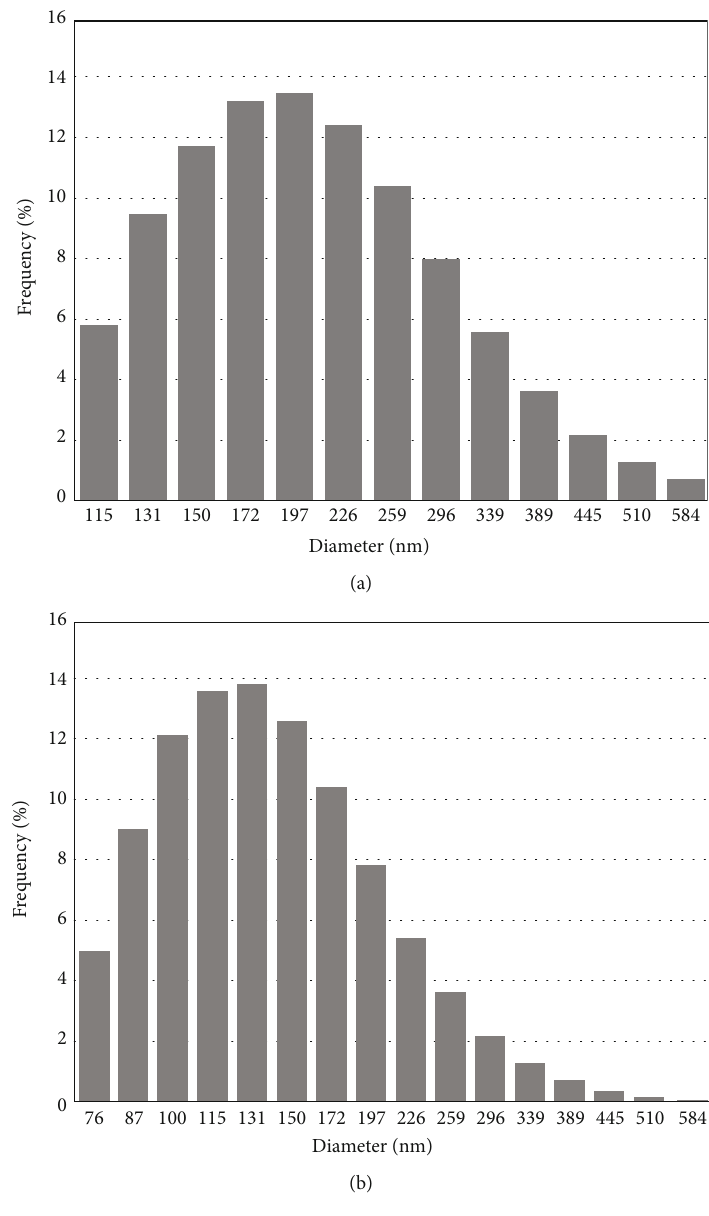
Figure 2: Particle size distribution of Cs-Al NDs in PBS at pH (a) 1.2 and (b)